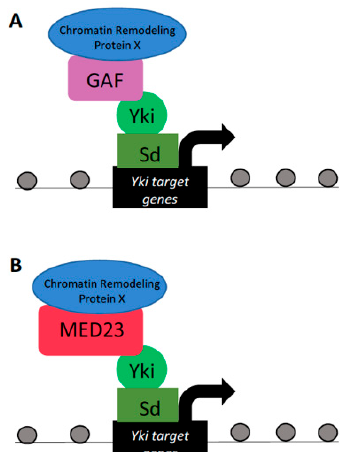
Figure 3. Yorkie interactions with GAF and the Mediator complex. Yki–Sd can interact with the chromatin protein GAF ( A ) or the Mediator complex subunit MED23 ( B ) to drive the transcription of Yki target genes that govern tissue proliferation. Although GAF and the Mediator complex do not contain intrinsic chromatin-remodeling capabilities, they are thought to recruit chromatin-remodeling proteins, yet to be identified, capable of modifying DNA organization.